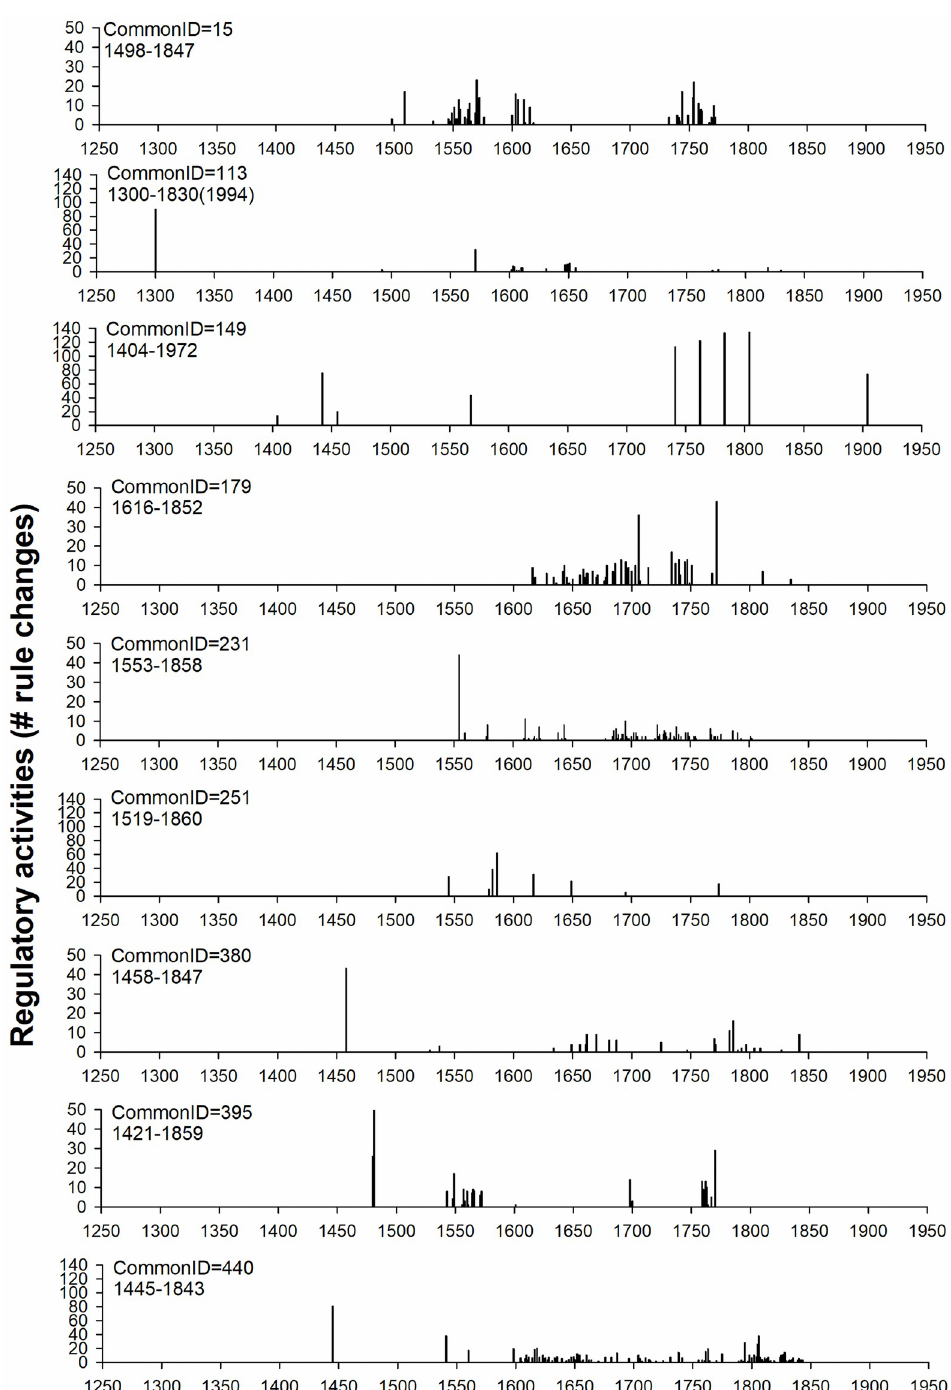
Fig 2. Temporal distributions of regulatory activities (rule changes) for nine Dutch commons. Key to Common IDs (15 = Mark Geesteren, Mander en Vasse, 113 = Mark Berkum, 149 = Mark het Gooi, 179 = Mark Exel, 231 = Dunsborger Hattemer mark, 251 = Mark Coevorden, 380 = Mark Bestmen, 395 = Mark Rozengaarde, 440 = Mark Raalterwold.